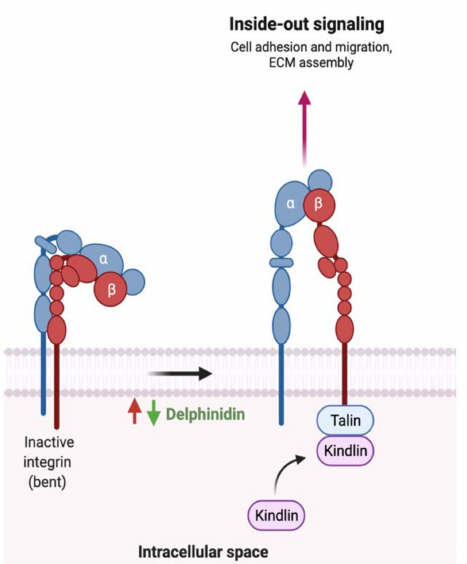
Figure 8. Schematic illustration of the impact of flavonoids on integrin activation. Red arrows represent the effects of GI cancer on the pathway, while the green arrows illustrate the impact of flavonoids on the pathway. Adapted from “Outside-in and Inside-out Integrin Signaling Pathways”, by BioRender.com (accessed on 3 August